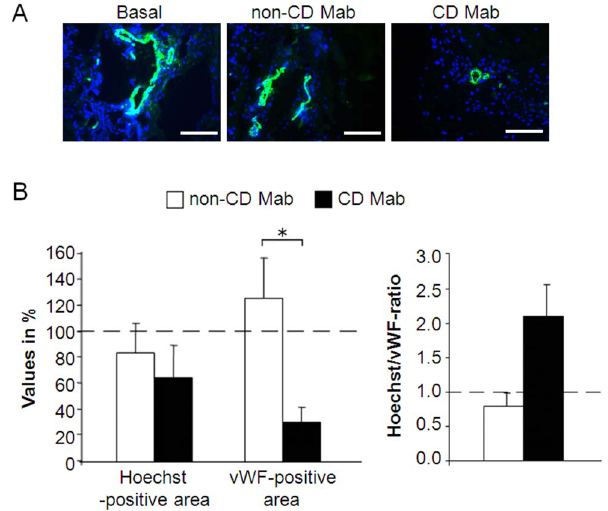
Figure 4. Functionality of vessels in mice in the presence of celiac patient-derived monoclonal autoantibodies (CD Mab) or their relevant controls (non-CD Mab). (A) Representative images of mouse matrigel implants were treated with CD Mab or non-CD Mab. Hoechst 33342 (Hoechst) was injected intravenously into a tail vein five minutes prior to euthanasia. The removed implants were stained for blood vessels with anti-von Willebrand factor (vWF)-antibody (green). Blue color indicates Hoechst-stained nuclei (DAPI) and scale bar represents 200 m m. (B) Vascular functionality parameters were deter- mined from matrigel implants (left panel) and the ratio of Hoechst- and vWF-positive area was calculated (right panel). (n=4 animals per group). Bars represent the average value as percentage + SEM. All data was normalized to the basal group (dotted line). * represents P # 0.05 statistical